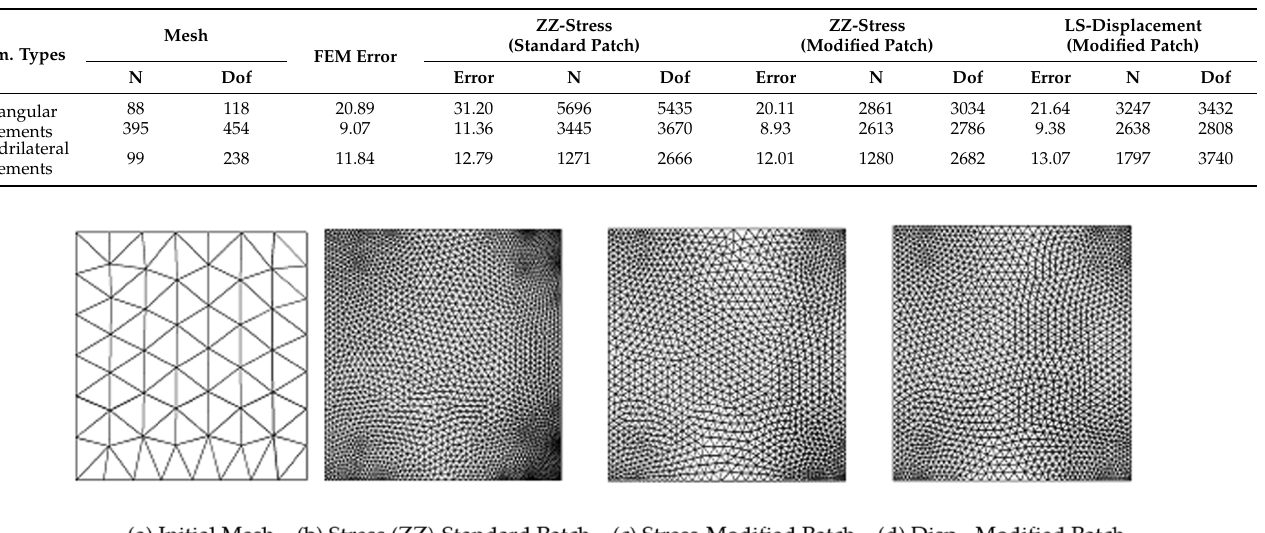
Figure 7. Adaptively modified mesh in benchmark plate problem using stress/displacement recovery and patch configuration (triangular elements initial mesh = 88.4% target error).